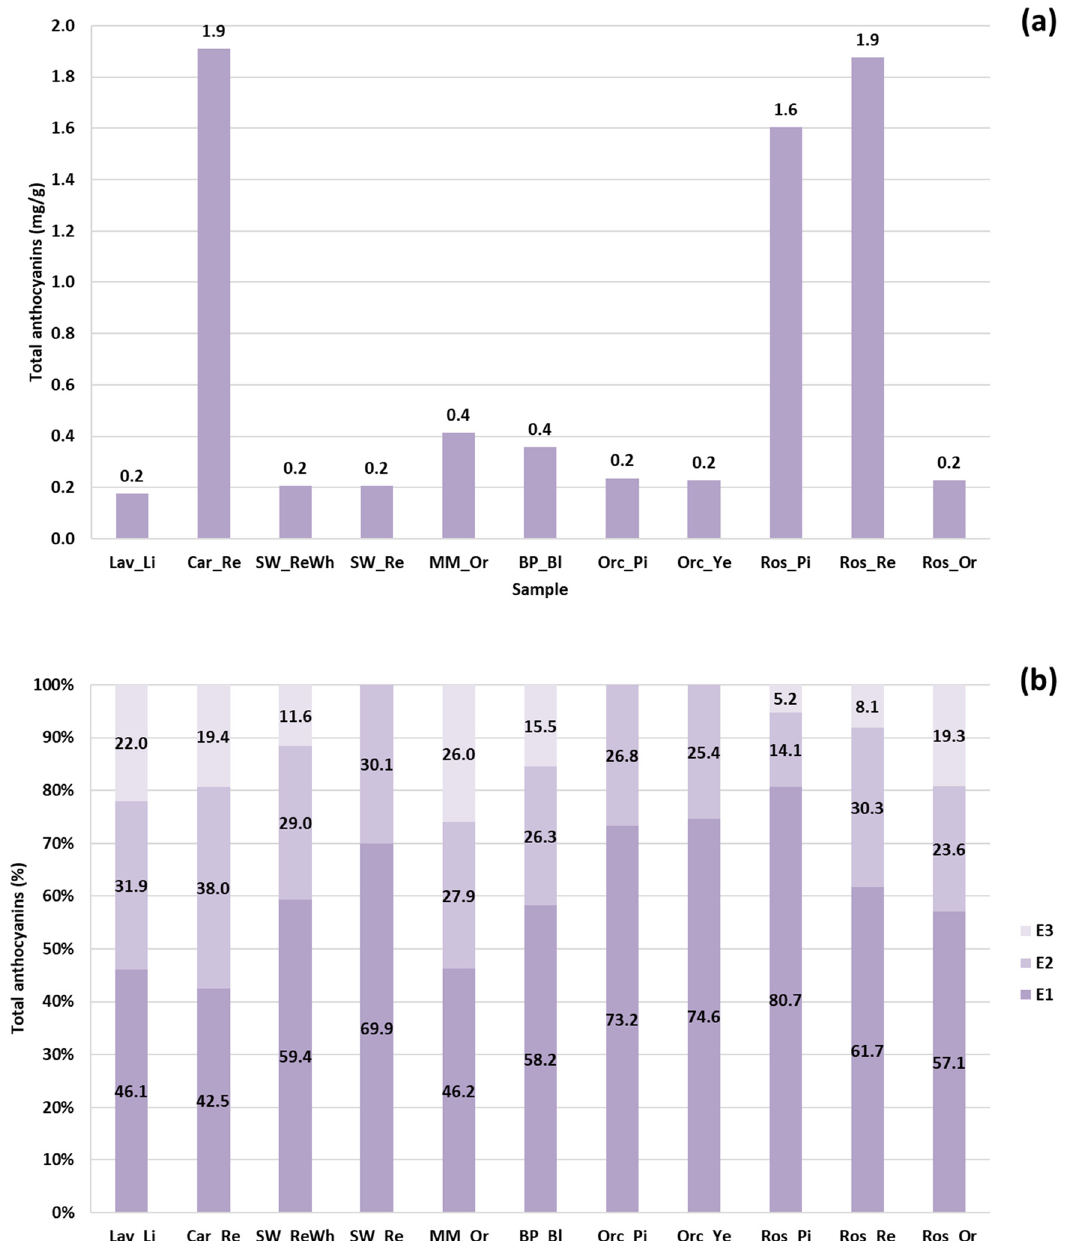
Figure 5: TA in the fi rst extraction ( a ) and relative percentage of three extractions ( b )